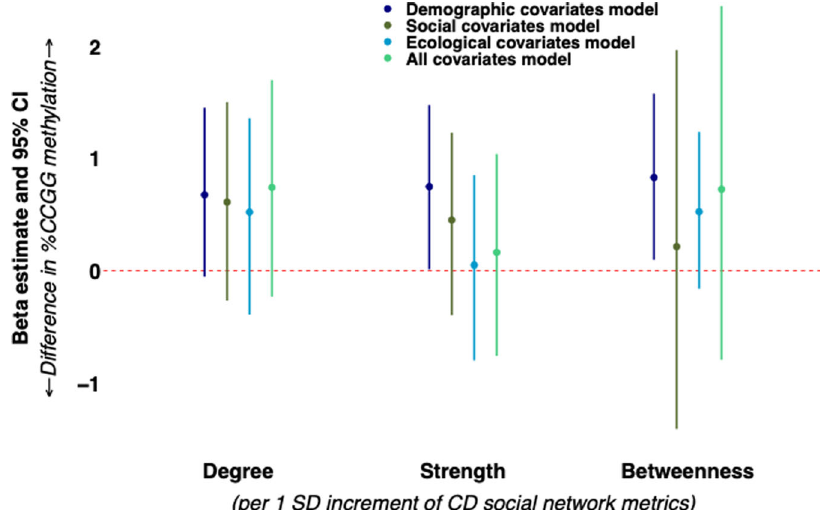
Fig. 2 Associations of hyena CD social network metrics with cub and subadult offspring %CCGG methylation among N = 81 hyenas. All models included a random intercept for maternal ID to account for relatedness, and the offspring ’ s age in months at the time of blood sample collection for DNA methylation quanti fi cation. Models were further adjusted according to four types of covariates (demographic covariates [dark blue], early social experience covariates [dark green], ecological covariates [light blue], and a fully adjusted all covariates model [light green]). 95% CIs were based on percentile bootstrapping (2000 iterations). Source data are provided as a Source Data fi le.